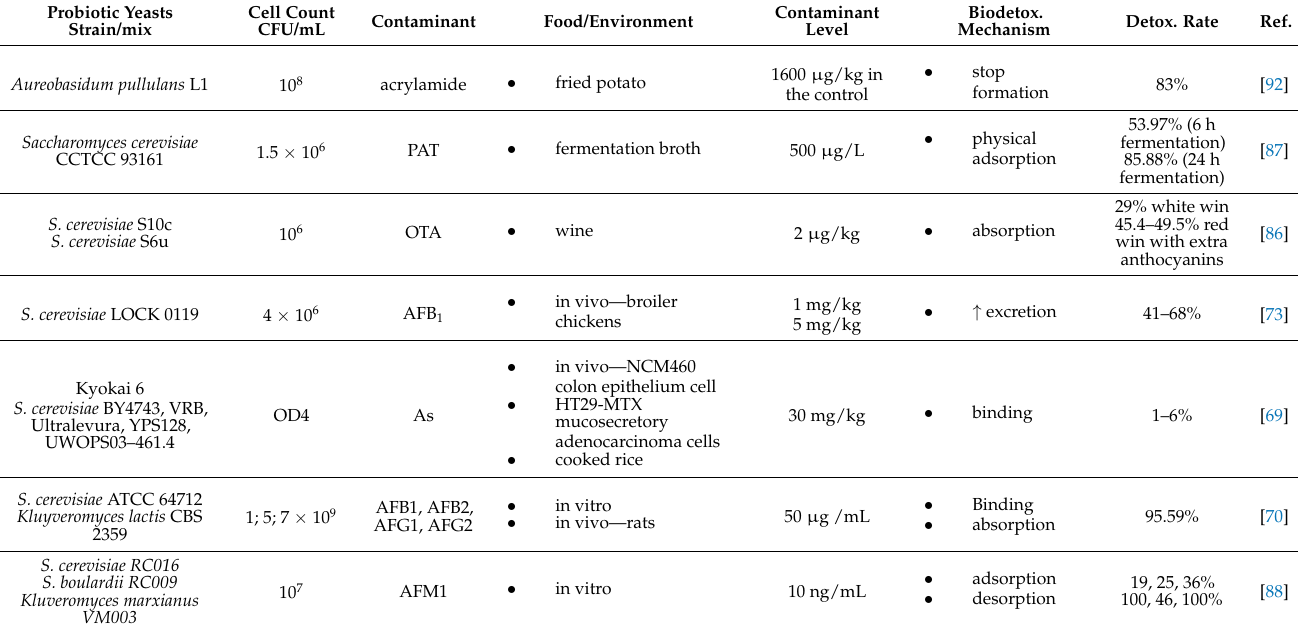
Table 3. Yeast strains, their biodetoxification mechanisms, and rates for different food contaminants. Probiotic Yeasts